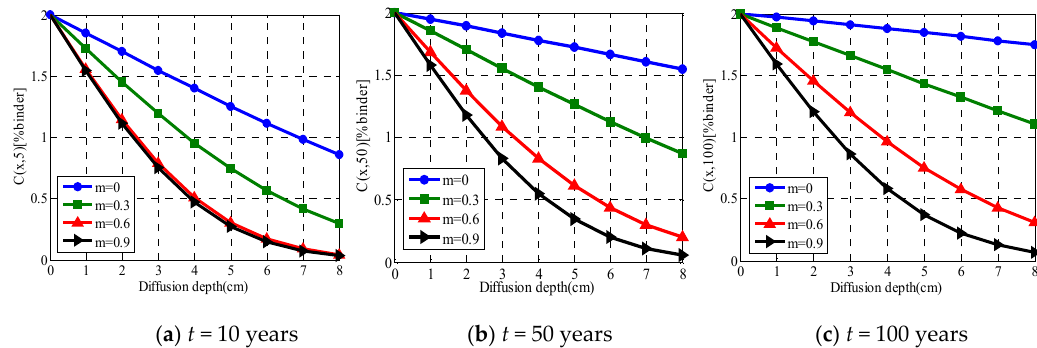
Figure 3. The influence of time-variant diffusion coefficients on chloride concentration distribution.